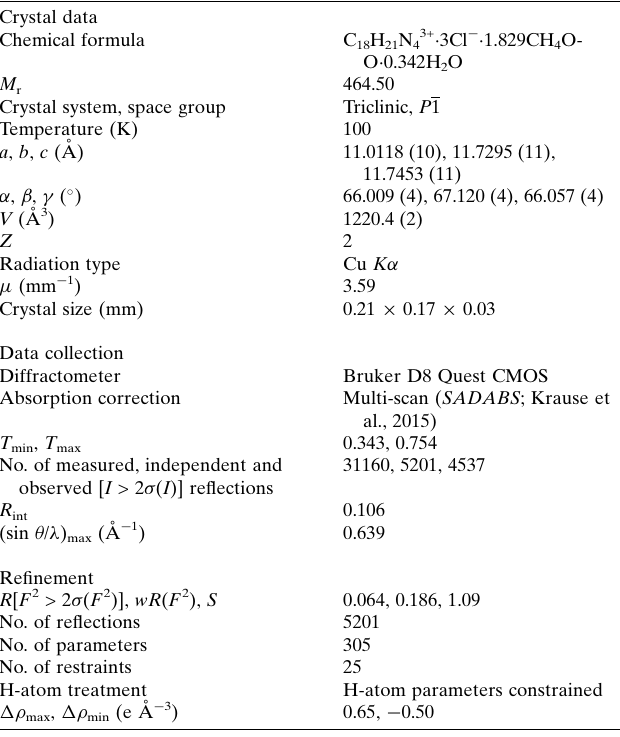
Table 2 Experimental details. Crystal data Chemical